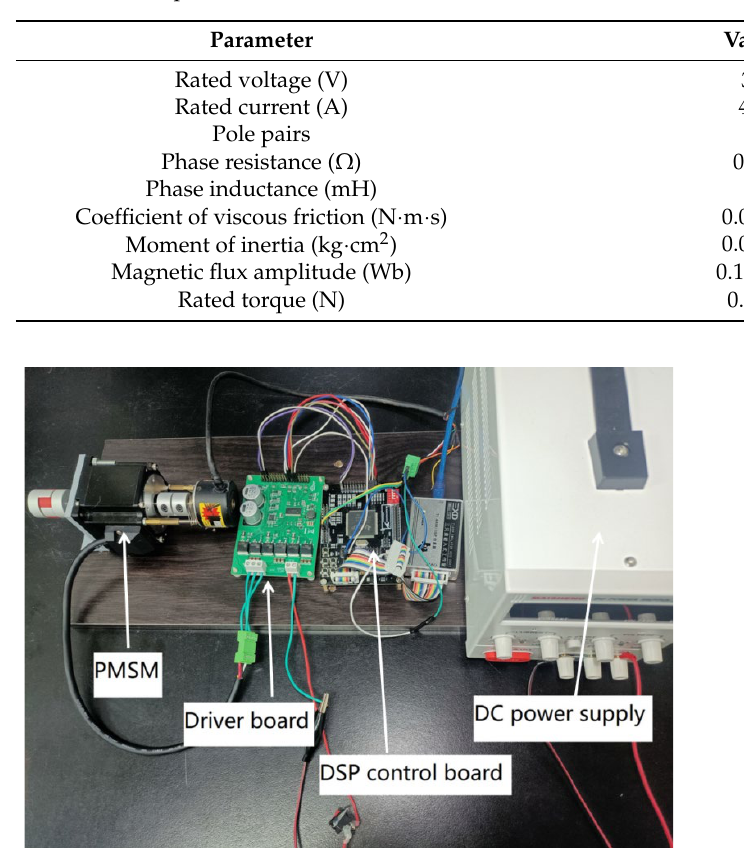
Figure 9. PMSM hardware diagram.